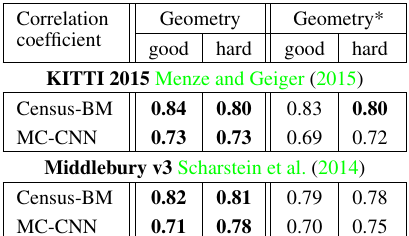
Table 2. Comparison of the two variants of the proposed geometry-aware model based on the correlation coefficient.